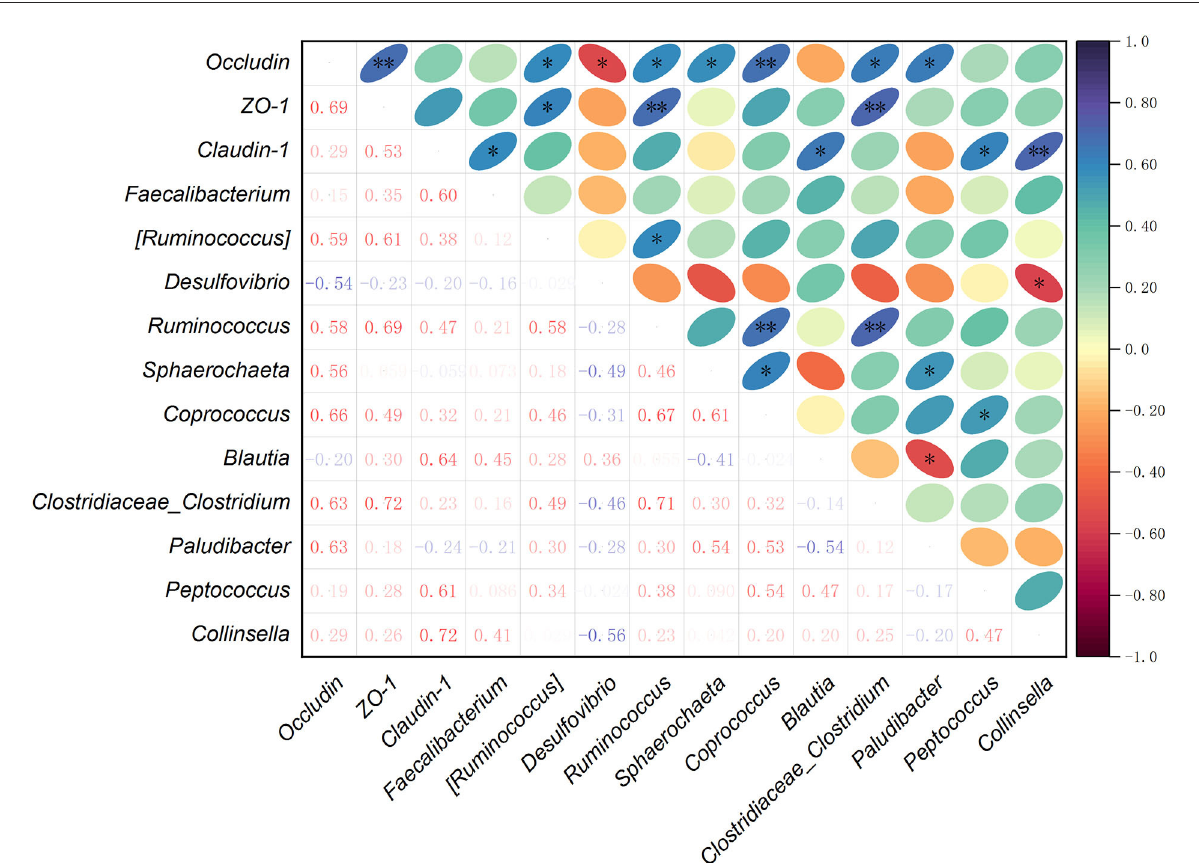
FIGURE5 Spearman’s correlation analysis among the mRNA expression levels of intestinal barrier-related genes and relative abundances of cecal bacteria selected from the top 35 genera. * P < 0.05, ** P < 0.01. The depth of colors ranging from red-purple to navy-blue represents the magnitude of correlation. Significant correlations are marked by * P < 0.05 and ** P < 0.01.